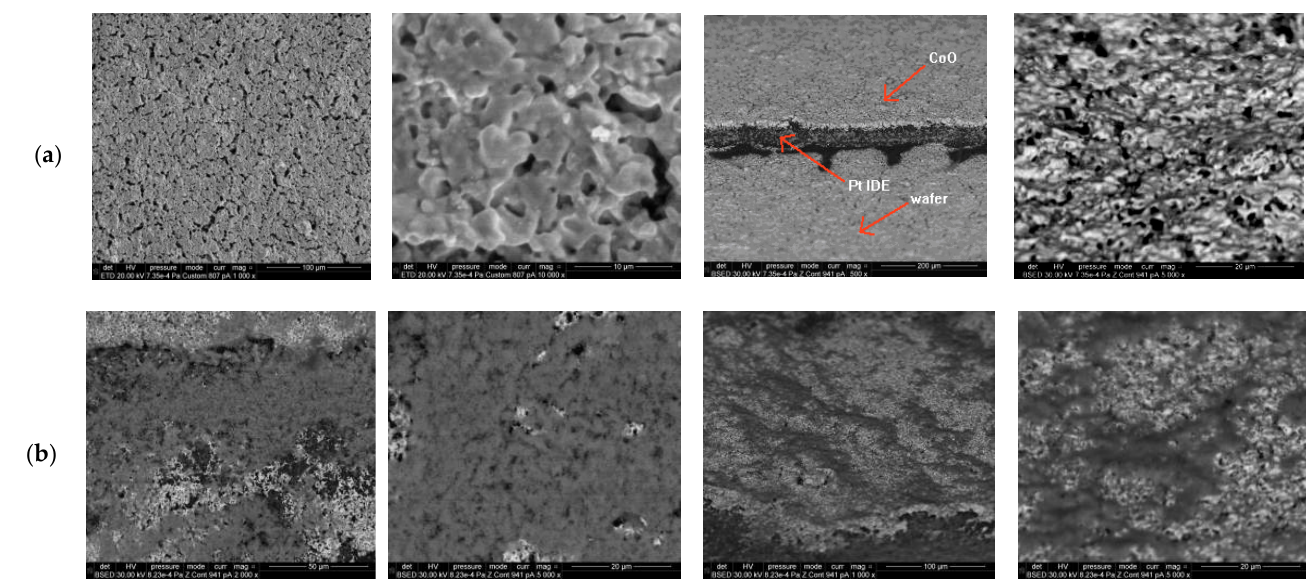
Figure 29. SEM images of ( a ) CoO sensitive film; ( b ) CuO sensitive film, at different magnification factors; last two images of each group ( a , b ) are tilted at a specific angle, from ref. [155].